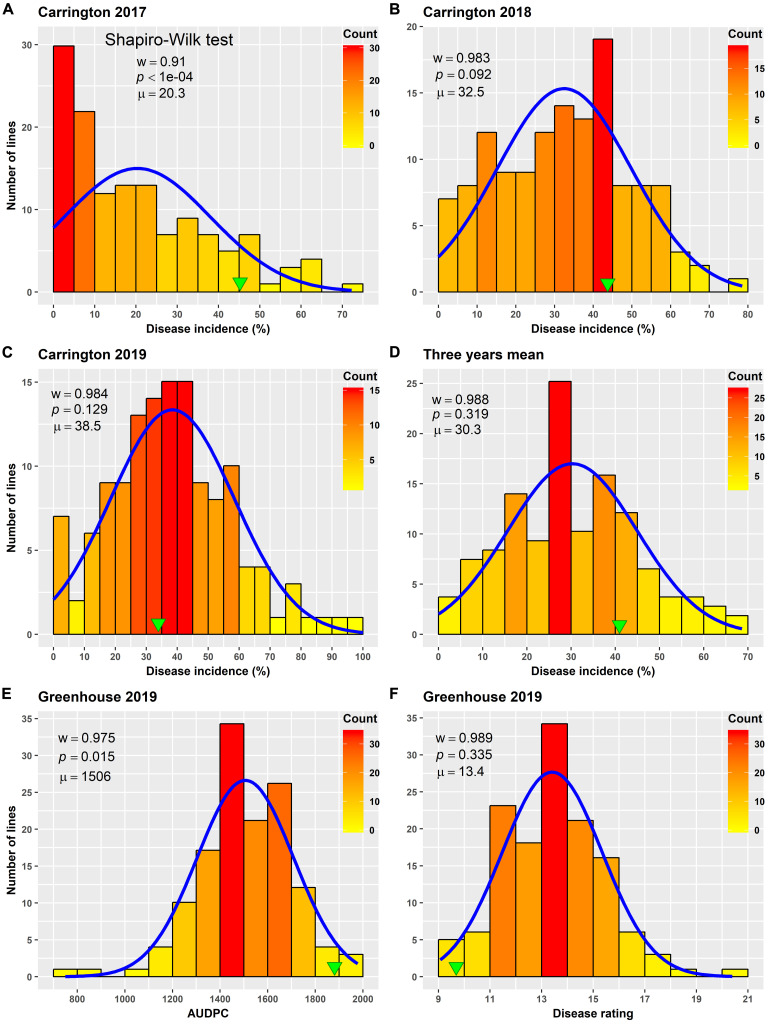
Frequency distribution of Sclerotinia basal stalk rot disease incidence (A–D), area under disease progress curve (E), and BSR disease rating (F) in an AB-QTL population evaluated in the field in Carrington, ND, United States during 2017 to 2019 (A–D) and in the greenhouse in 2019 (E,F). The green arrowheads indicate the value of the recurrent parent HA 89. The Shapiro–Wilk normality test statistic (w), the probability value (p), and the mean (μ) of the data for each environment are shown inside the respective plots.